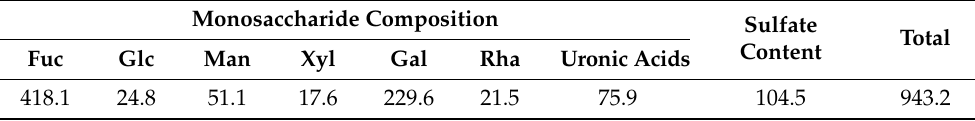
Table 1. Fucoidan monosaccharide composition and sulfate groups content ( µ g/mg fucoidan ). Monosaccharide